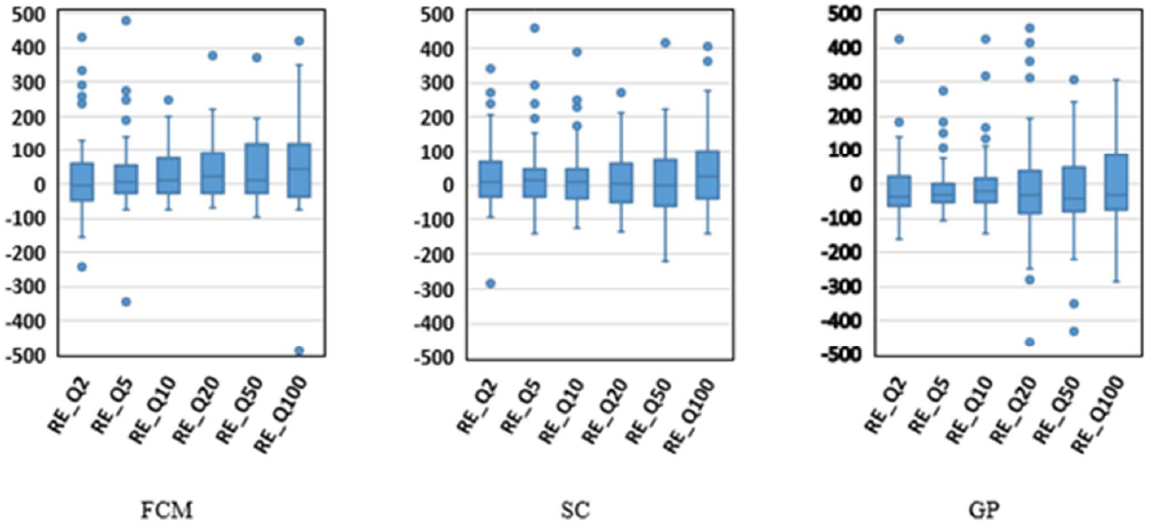
Figure 3. Boxplot of RE values for FCM, SC, and GP-based RFFA models.